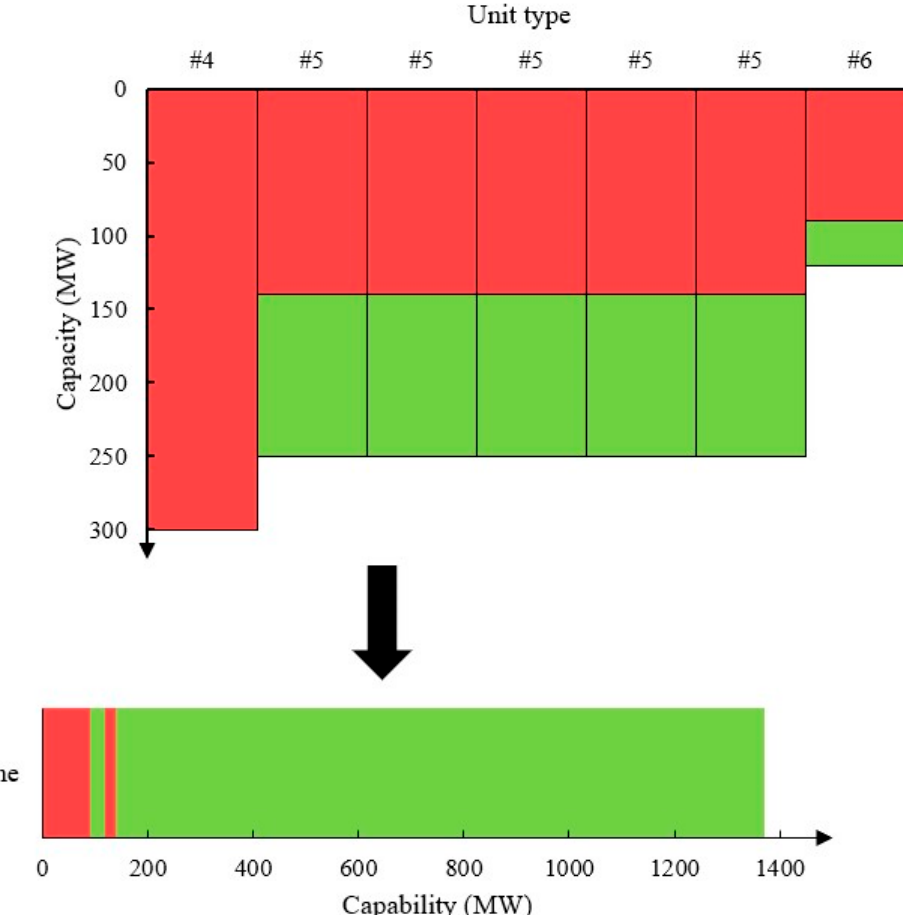
Figure 3. Results of Manwan by combining units into plant ‐ based operating zones.